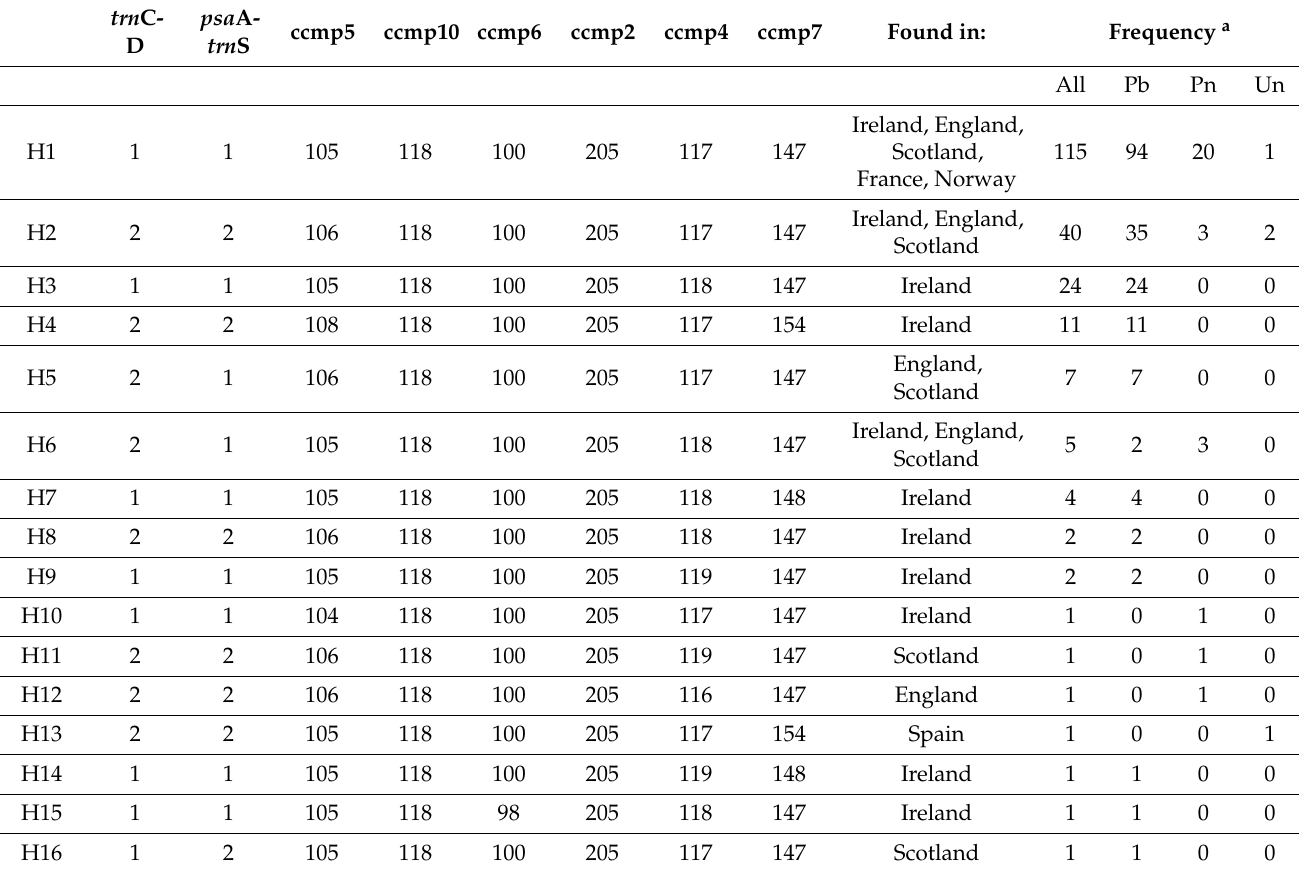
Table 3. List and composition of haplotypes detected. The locations and frequencies are shown for each haplotype. The frequencies are presented for all individuals and then separately for B. pubescens (Pb), B. pendula (Pn), and putative hybrids